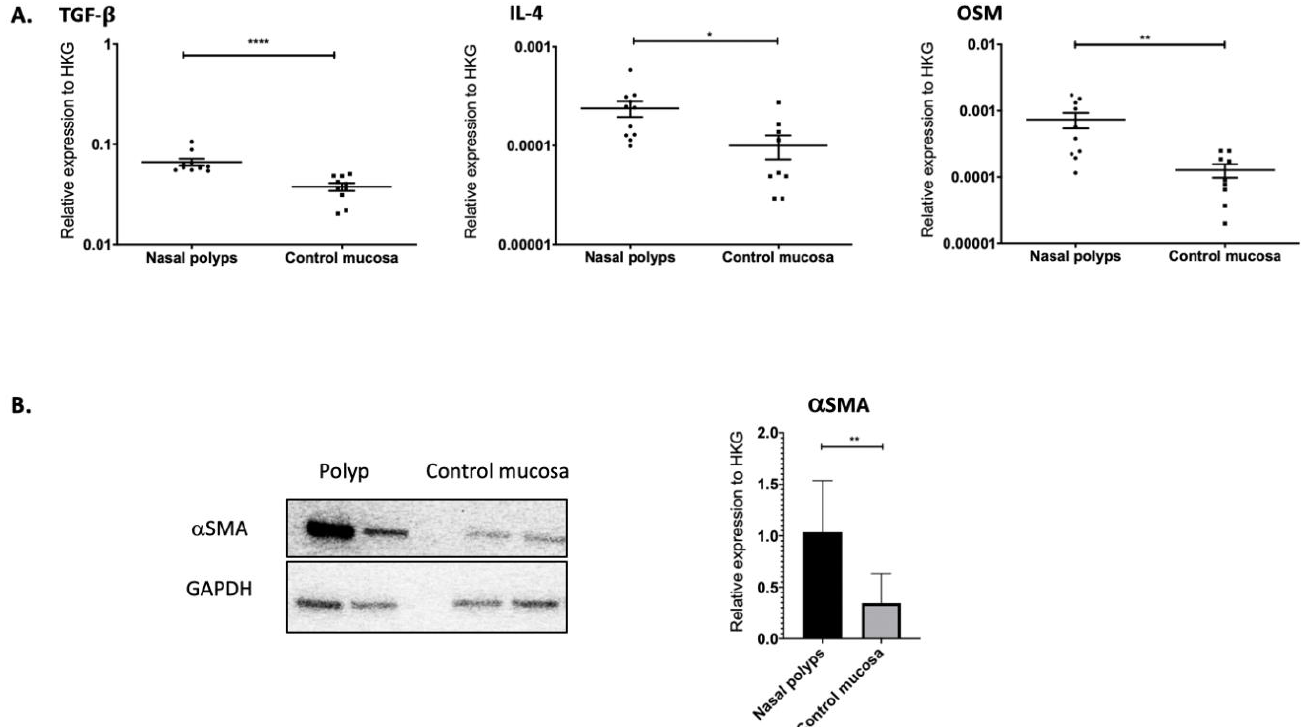
Figure 1. TGF- β 1, IL-4 and OSM were overexpressed in nasal polyps ( n = 13) when compared to noninflammatory nasal mucosa ( n = 13). TGF- β 1, IL-4 and OSM were analyzed by RT-qPCR using GAPDH as housekeeping gene to normalize gene expression (median) ( A ). α SMA was overexpressed in nasal polyps ( n = 6) when compared to noninflammatory nasal mucosa ( n = 6). α SMA was analyzed by Western blot using GAPDH as housekeeping gene to normalize gene expression. The image is representative of two experiments. The graph shows the relative expression of each gene compared to the expression of the housekeeping gene (HKG) ( n = 6) ( B ). **** p < 0.0001; ** p < 0.005; * p < 0.05.